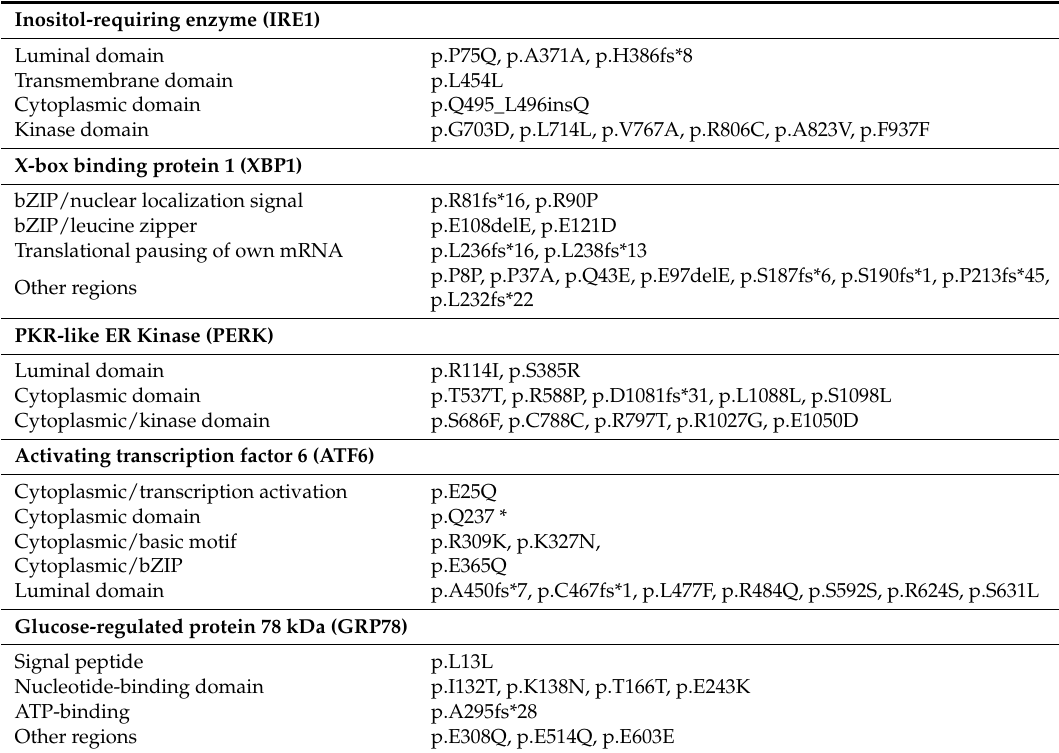
Table 1. Catalog of Somatic Mutations in Cancer (COSMIC) Database Interrogation for Unfolded Protein Response (UPR)